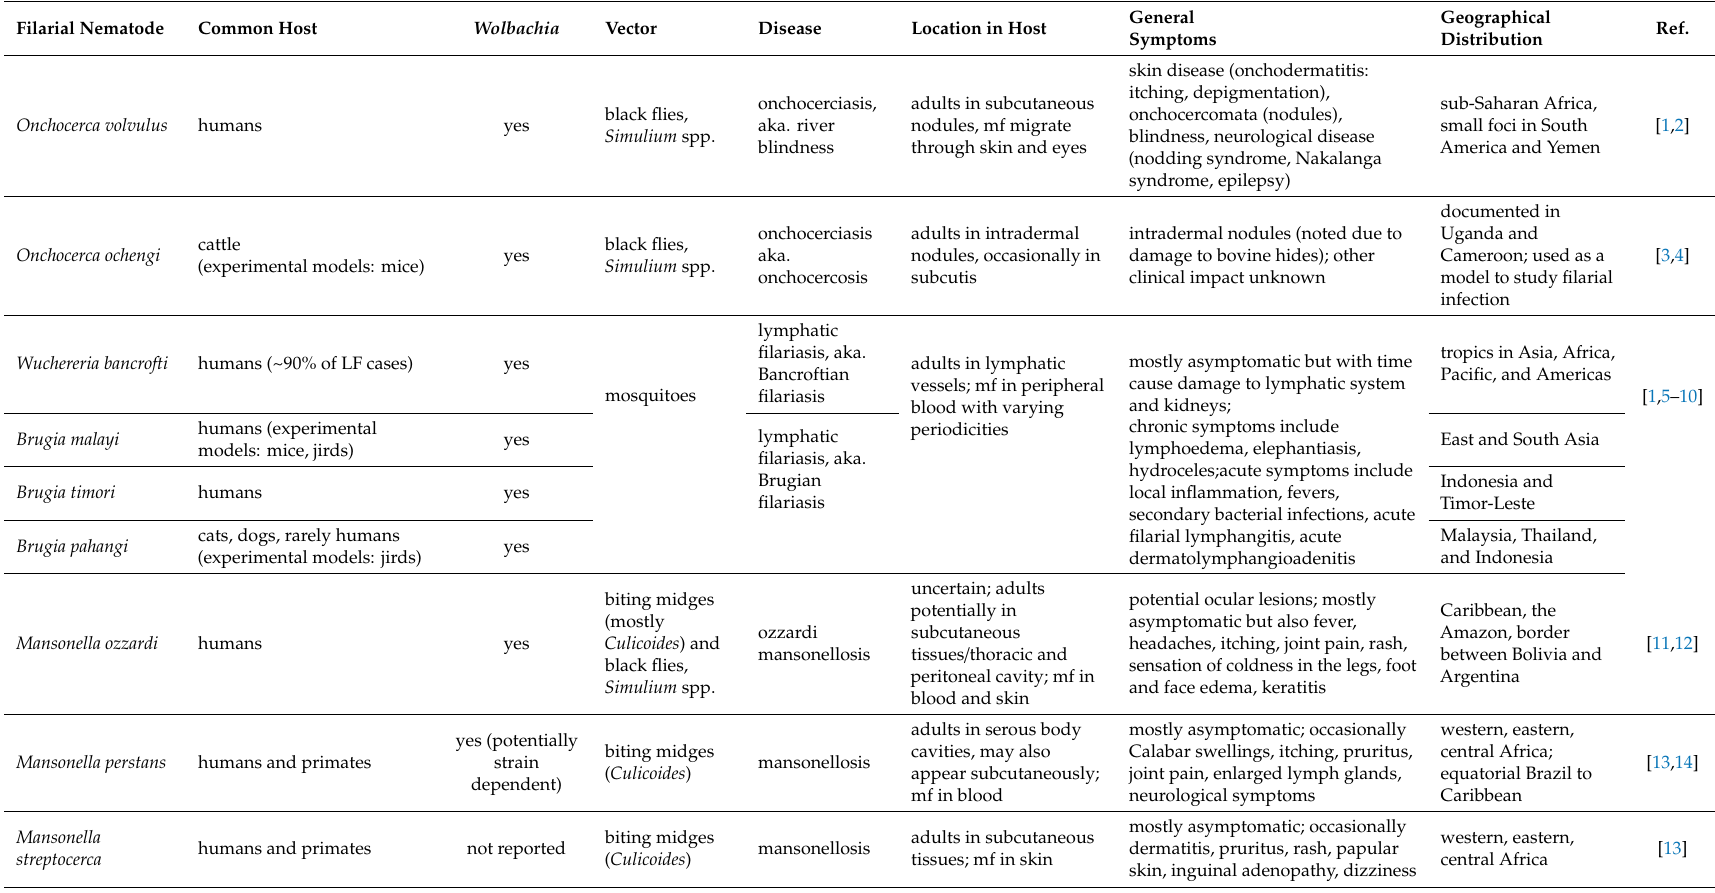
Table 1. Overview of parasitic filarial nematodes pertinent to the antiwolbachial